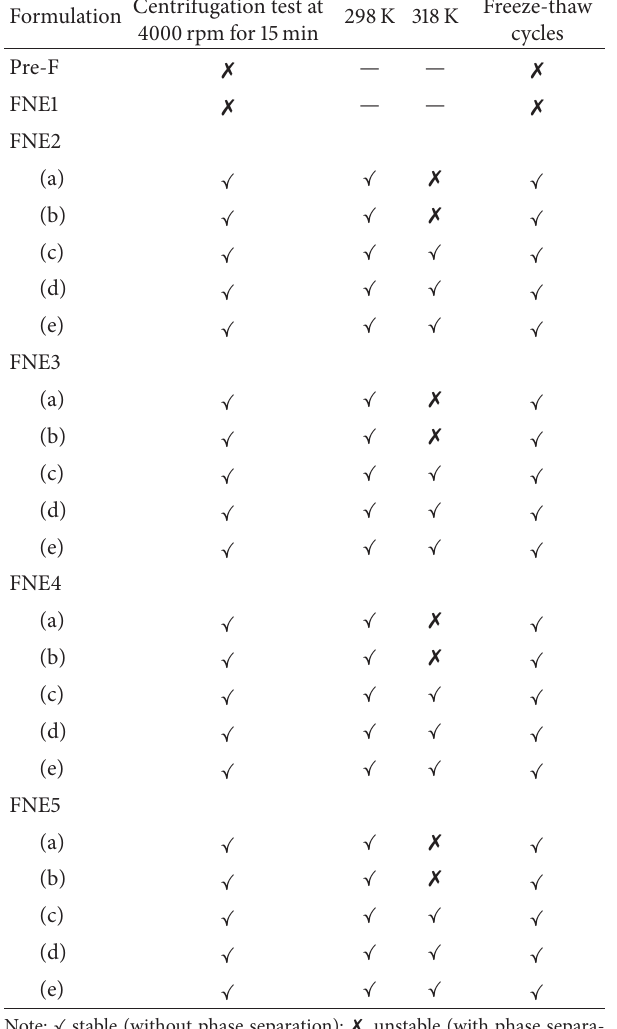
Table 6: Accelerated stability assessment of the Pre-F and FNEs. Formulation Centrifugation test at 4000 rpm for